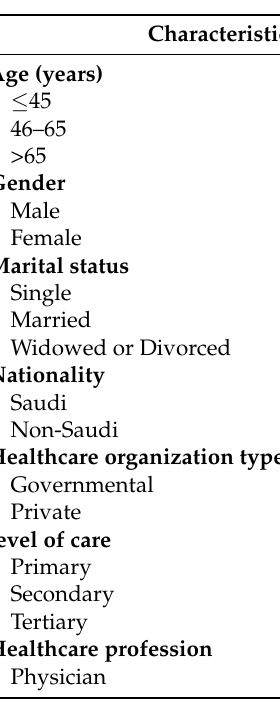
Table 1. Participants’ demographic and professional characteristics (N =